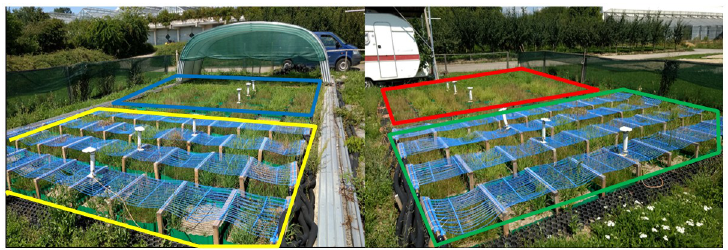
Fig 1. Experimental setup in Du¨rnast (48.404457˚N, 11.690464˚E). Right side: control (red) and warming treatment (green); Left side: drought treatment (blue), warming + drought treatment (yellow area).